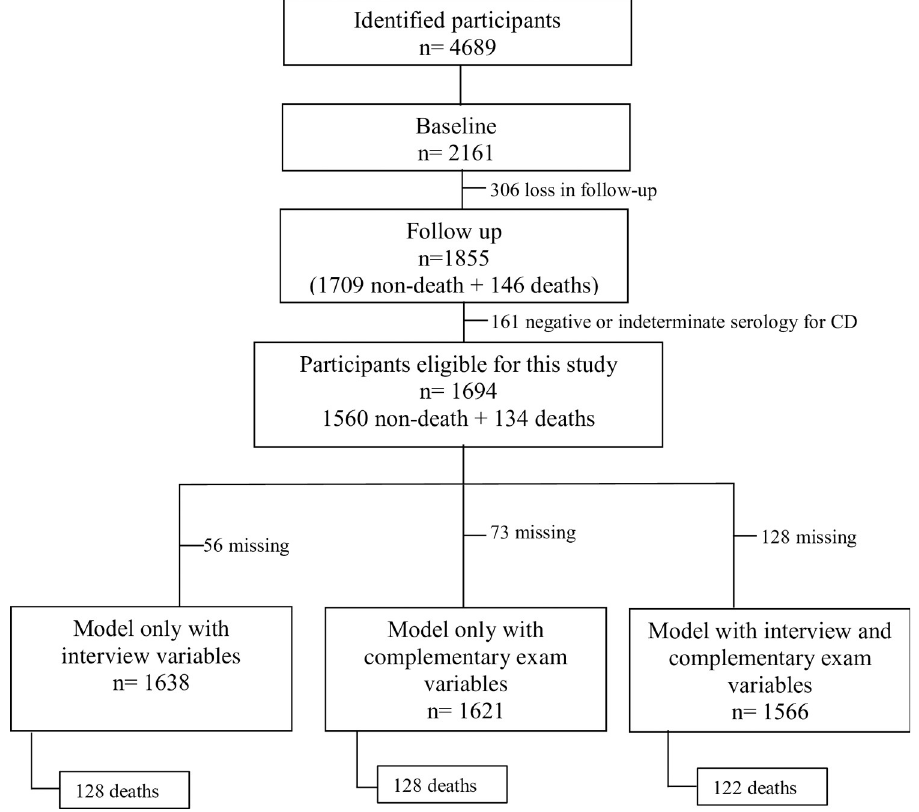
Fig 2. Flowchart of patients included and excluded from the cohort and of eligible patients in the study and in the models obtained. SaMi-Trop Project. Minas Gerais.